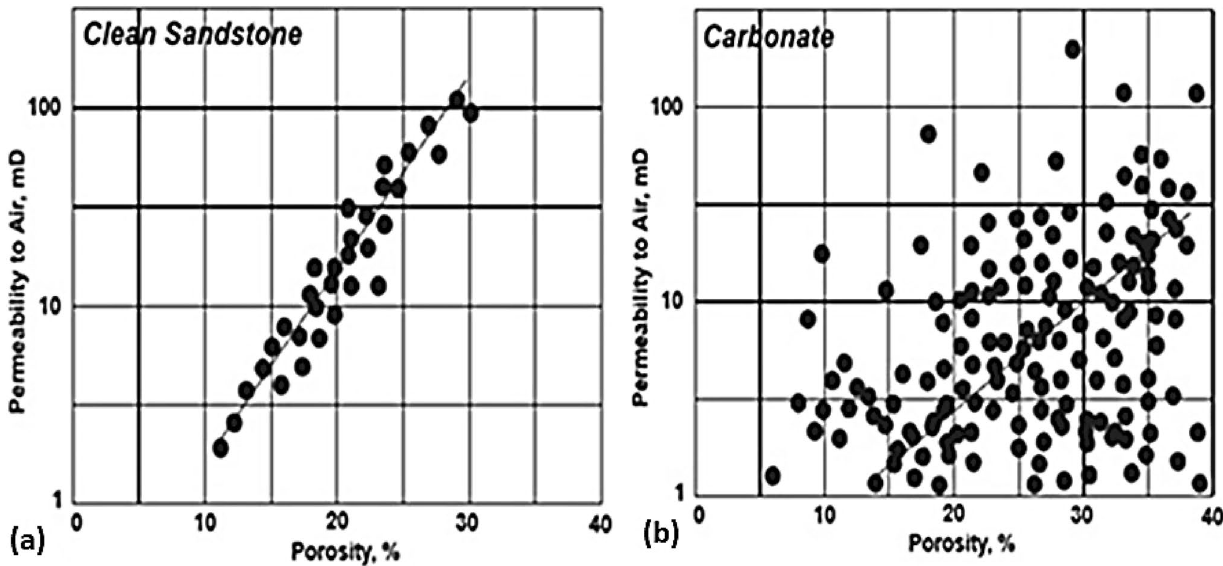
Fig. 10 Typical porosity vs. permeability cross-plot for a clean sandstone and b carbonate (Arwini, 2020). High scatter indicates high heteroge- neity and hence carbonate reservoirs